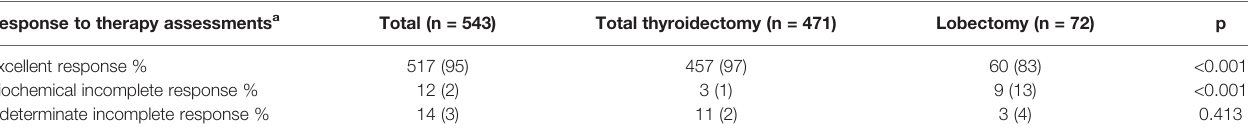
TABLE 3 | Response to therapy assessments at the last follow-up in the study subjects.